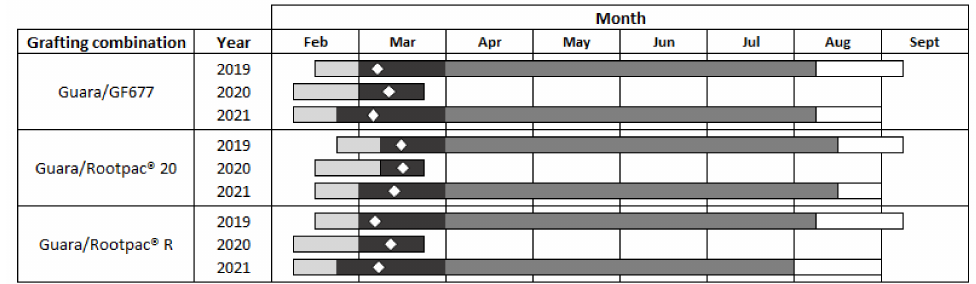
Figure 2. Phenograms of blooming and ripening recorded over four years of investigation (2018–2021) for cultivars ‘Guara’ grafted on clonal rootstock ‘GF677’, ‘Rootpac ® 20’ and ‘Rootpac ® R’, re- spectively (light grey histogram = beginning flowers emergence; dark grey histogram = blooming; white dots = overlapping of successive phenological stages; mid-dark grey histogram = fruit devel- opment; white histogram = fruit maturity: 1% hull